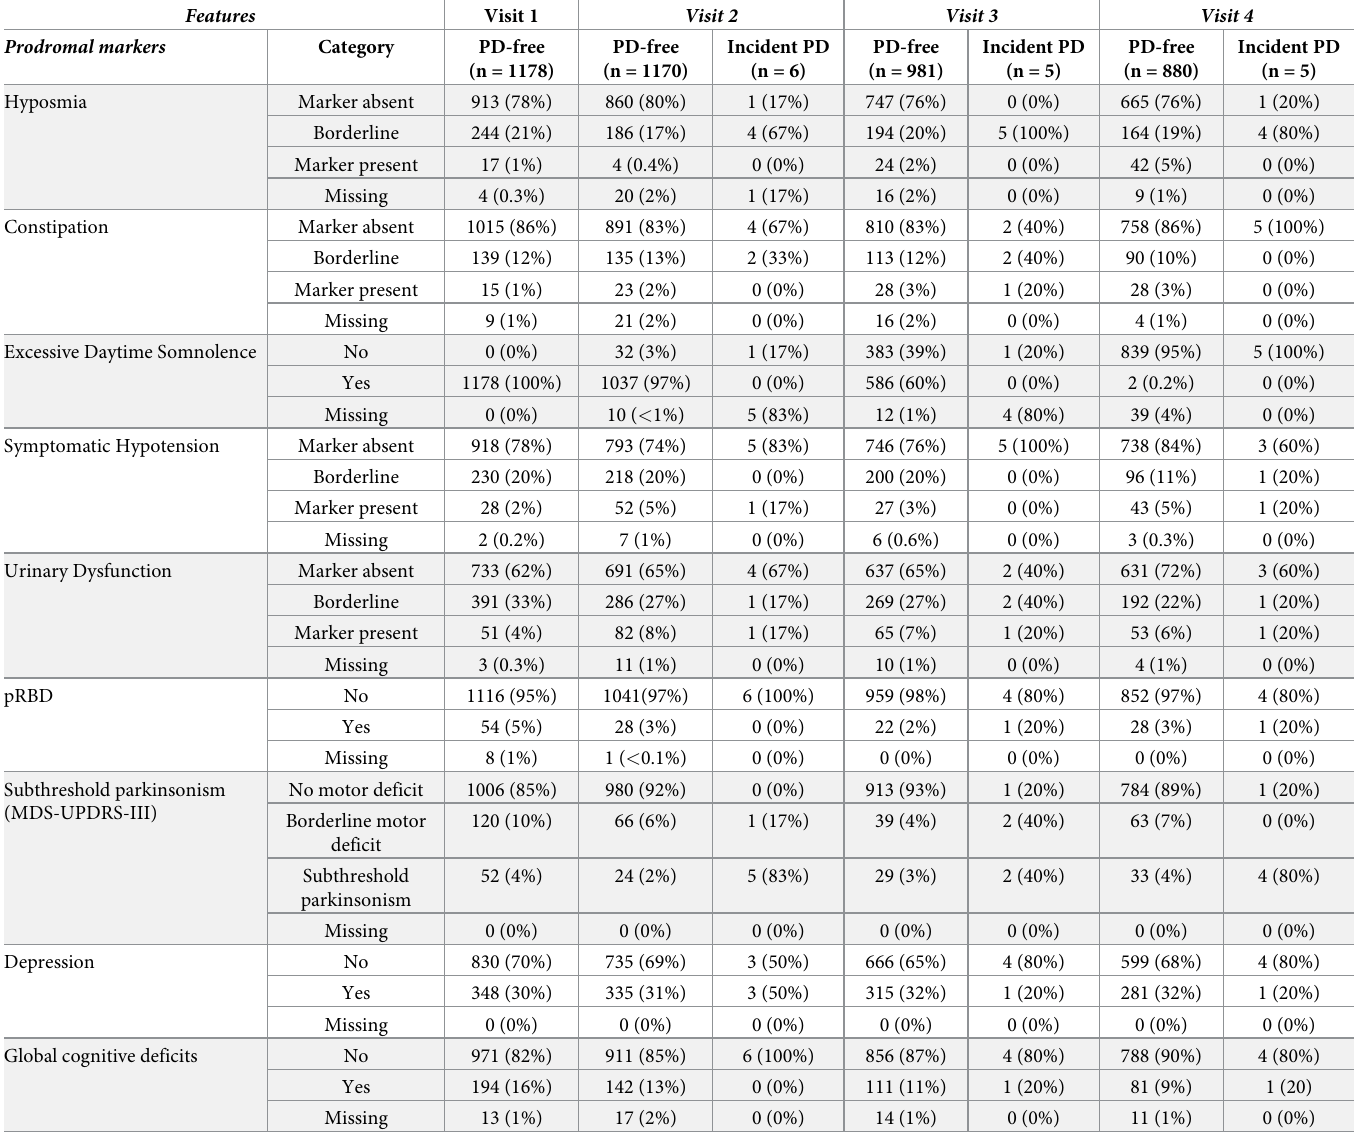
Table 2. Prodromal markers of PD in the prospective TREND